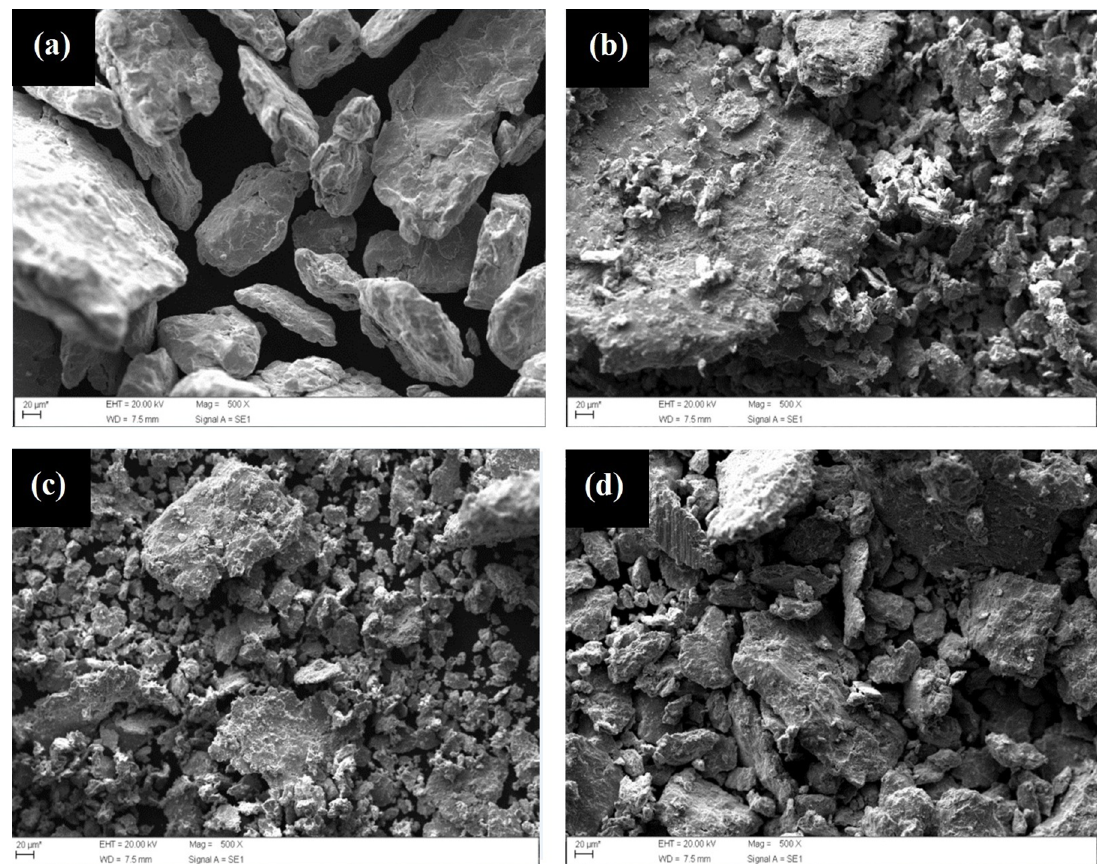
Figure 1. SEM of the AISI 52100 steel milled through 5 hours with (a) 0% of alumina (b) 1% of alumina (c) 3% of alumina (d) 5% of alumina